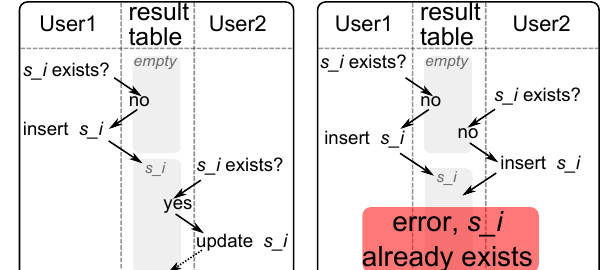
Figure 12: Left, a classical upsert. Right, race condition produces an error.